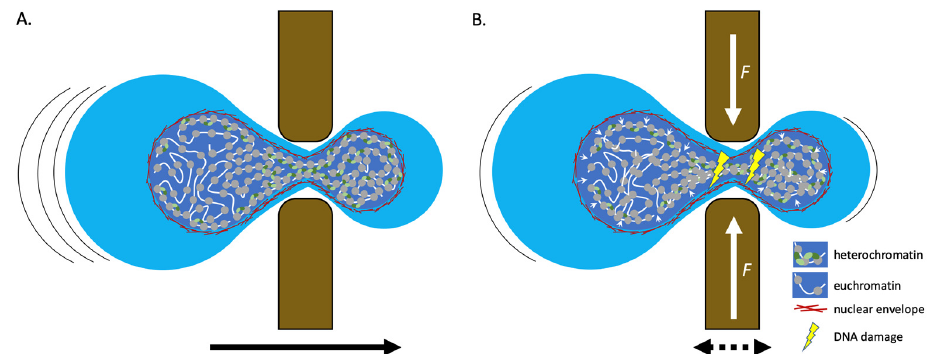
Figure 2. Chromatin dynamics during migration. ( A ) When a cell migrates (black arrows) through a small space, resulting in extensive compression of the cellular interior, chromatin tends to become hyper condensed. As we predict that heterochromatin is more gel-like than euchromatin, this might facilitate the nucleus to move through the gap faster, in a capillary suction-like manner. ( B ) When a cell is exposed to extensive compression forces (white arrows) or is stuck in a gap, the chromatin will eventually detach from the nuclear envelope and becomes more susceptible to DNA